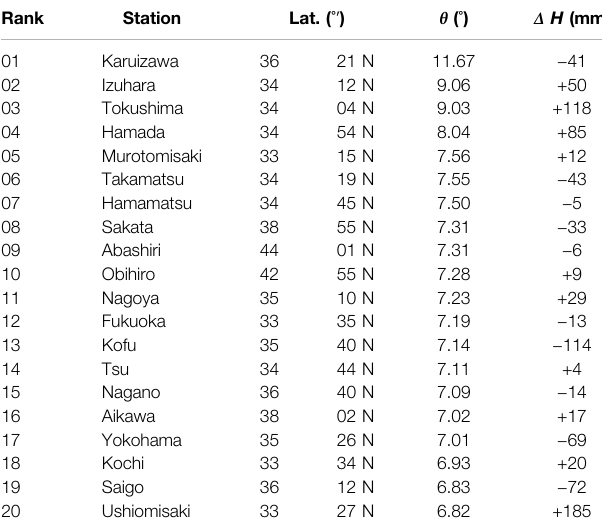
TABLE3A| Top-twentyJapanesestationsintheintersectingangleofthemonthly temperatures from Period I (from 1931 to 1960) to Period II (from 1951 to 1980).